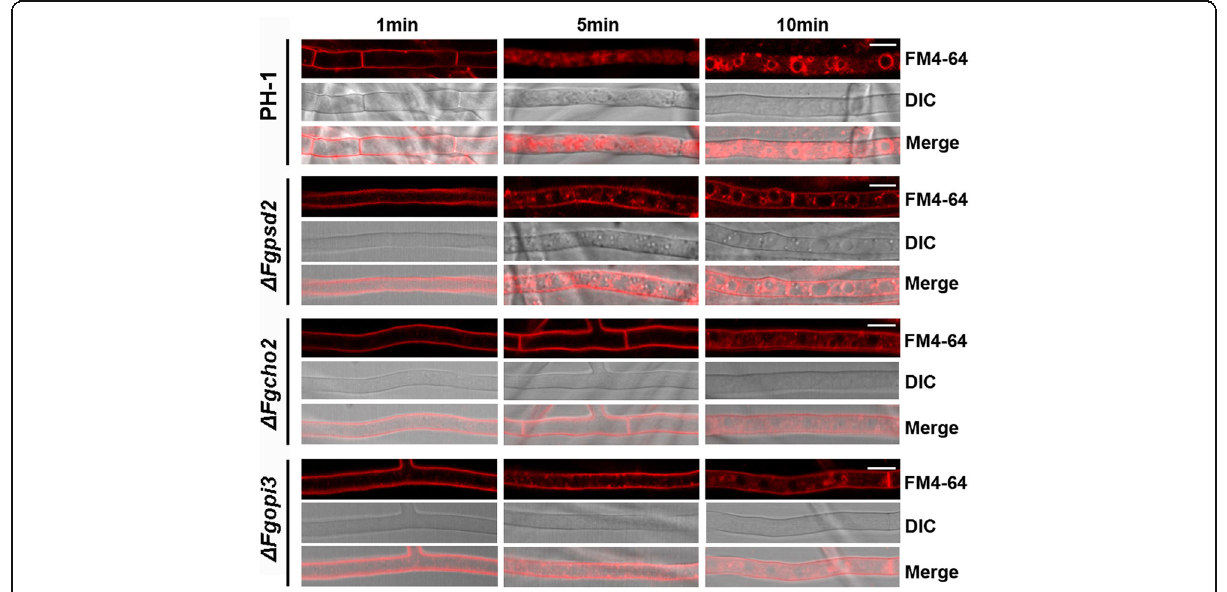
Fig. 6 Deletion mutants of the de novo pathway exhibited impaired fungal endocytosis. Mycelia of the wild-type strain and mutants were stained with FM4 – 64 and observed via microscopy. Images were acquired at 1, 5 and 10 min after staining. Bar = 20 μ